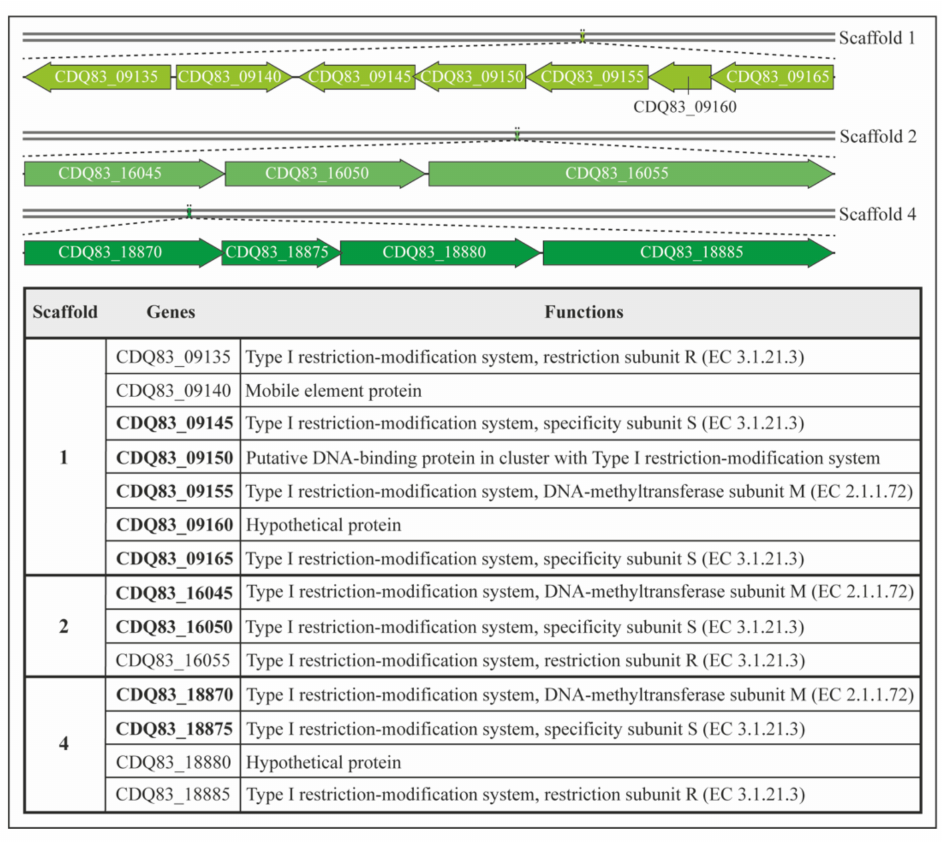
Figure 2. Type I RM systems in the genome of P. thermosuccinogenes DSM 5809. Genetic maps with gene functions of the different type I RM systems in P. thermosuccinogenes . Scaffold 1 har- bors the gene cluster CDQ83_09135, CDQ83_09140, CDQ83_09145, CDQ83_09150, CDQ83_09155, CDQ83_09160, and CDQ83_09165. Scaffold 2 harbors the gene cluster CDQ83_16045, CDQ83_16050, and CDQ83_16055. Scaffold 3 harbors the gene cluster CDQ83_18870, CDQ83_18875, CDQ83_18880, and CDQ83_18885. The ORFs from each Type I RM systems cloned in E. coli are highlighted in